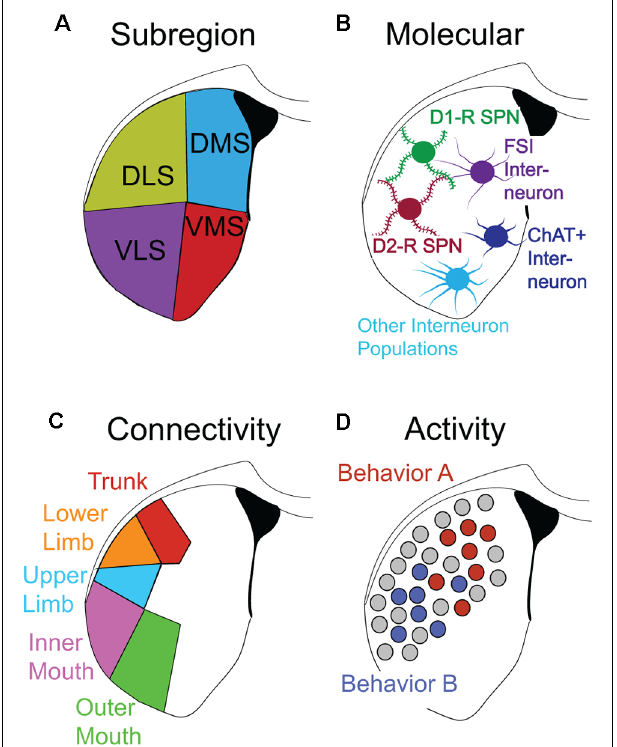
FIGURE 2 | Functional definitions of striatal neurons. (A–D) Different dimensions/layers/’masks’ describing striatal neurons. (A) Striatal subregion. (B) Molecular/genetic: principal striatal cell types include Drd1+ SPNs, Drd2+ SPNs, PV+ FSIs, ChAT+ cholinergic interneurons, and several other important subtypes of interneuron populations. (C) Homuncular: striatal cells preferentially receive inputs from different regions of cortex. Sensorimotor inputs corresponding to specific body parts map to specific regions of the striatum adapted from Robbe (2018). (D) Task-specific recruitment: segregated clusters of neurons recruited by specific behavioral sequences (Behavior A vs. Behavior B) are